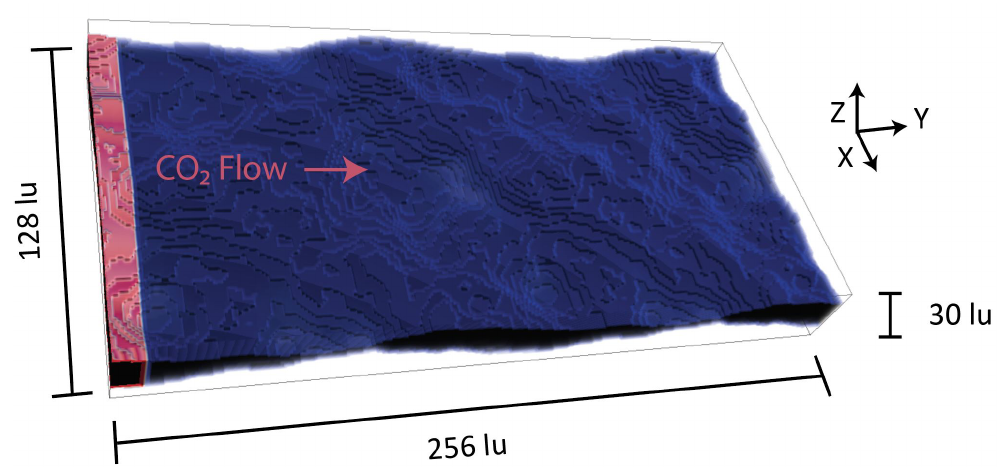
Figure 1. Model domain. The model domain is 128 × 256 × 30 lu with a constant pressure inlet at y = 0 and a lower constant pressure outlet at y = 256. scCO 2 (red) is initialized in the first 10 lu in the y -direction while the remaining model is brine (blue). The pressure gradient across the domain is equivalent to 500